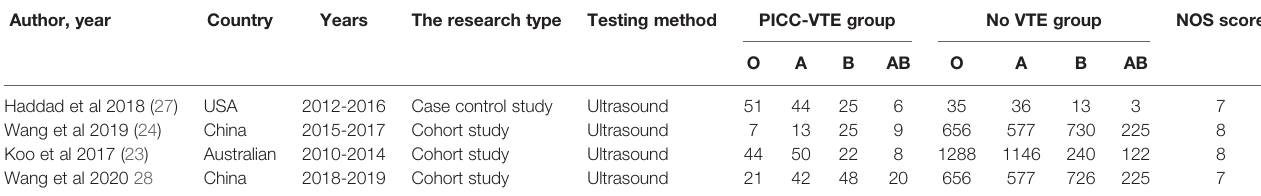
TABLE 1 | General characteristics of the included studies.